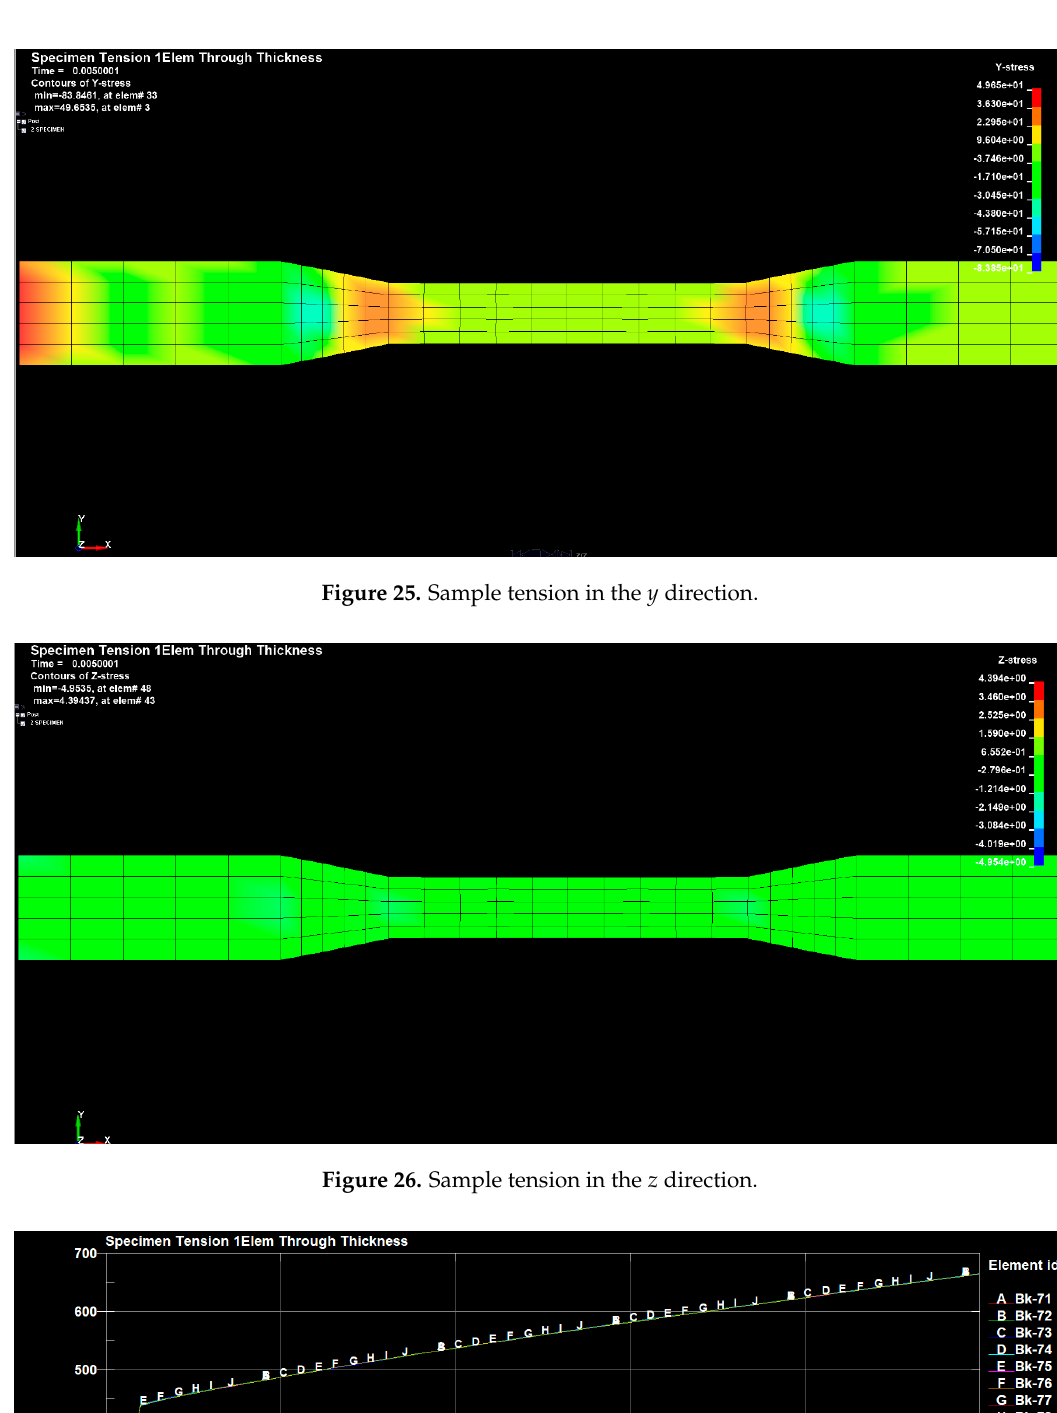
Figure 24. Sample tension in the 𝑥 direction.